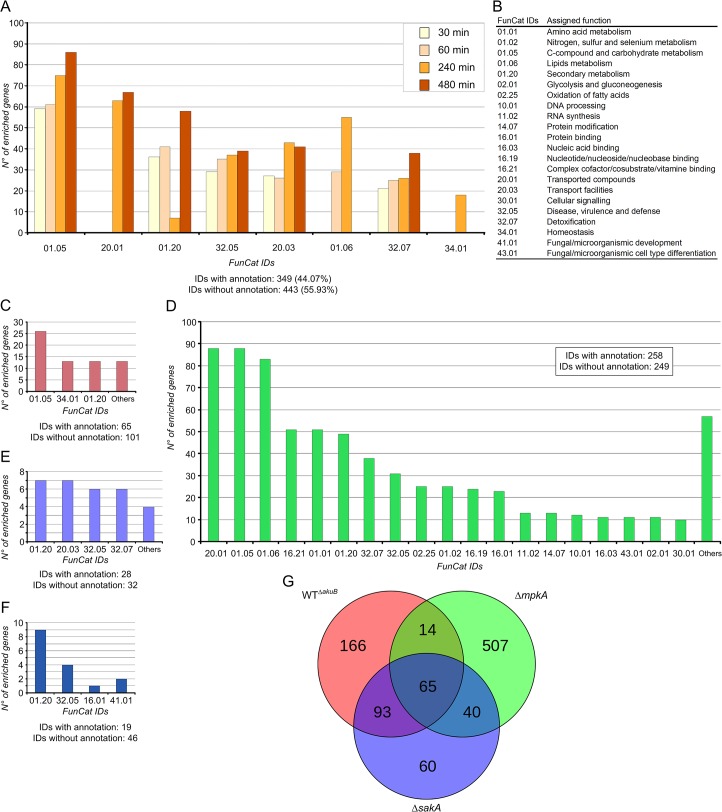
FunCat-enriched categories during caspofungin stress.FunCat-enriched categories were obtained by analyzing the total number of genes differentially expressed in response to caspofungin (0.1 μg ml-1). Enrichment analysis using selected genes having log2 fold change > 2, and p-value <0.01. The identified FunCat IDs are shown on the x-axis. (A) FunCat-enriched categories identifiedin A. fumigatus CEA10 wild-type strains during caspofungin stress at the reported time points, and (B) a table showing all the identified categories displayed on the x-axes. Comparative analyses of selected genes in the A. fumigatus ΔakuB, ΔsakA and ΔmpkA mutant strains are shown. Categorization was implemented by considering differentially regulated genes identified at 3 different time points (0, 1 and 4 h after induction, for all selected mutant strains). In the picture are shown the FunCat-enriched categories uniquely identified in the ΔakuB (wt) strain (C), in the ΔmpkA strain (D), and in the ΔsakA strain (E). Categorization of genes differentially regulated in all strains (F), and the obtained Venn diagram (G), are also shown. Genes used for the analysis are reported in the S2 Database.